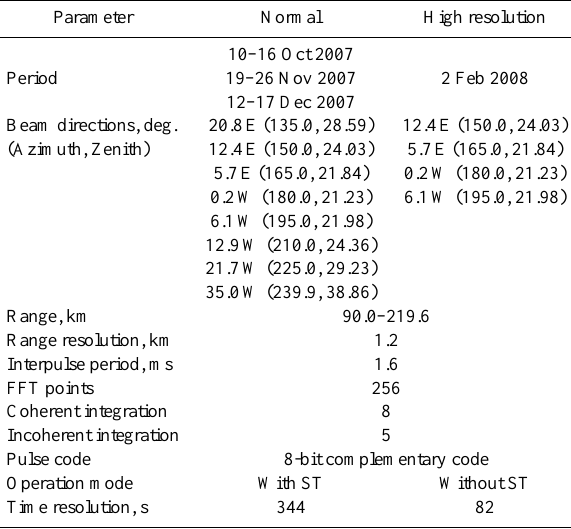
Table 1. Experimental specifications used for the observations. Parameter